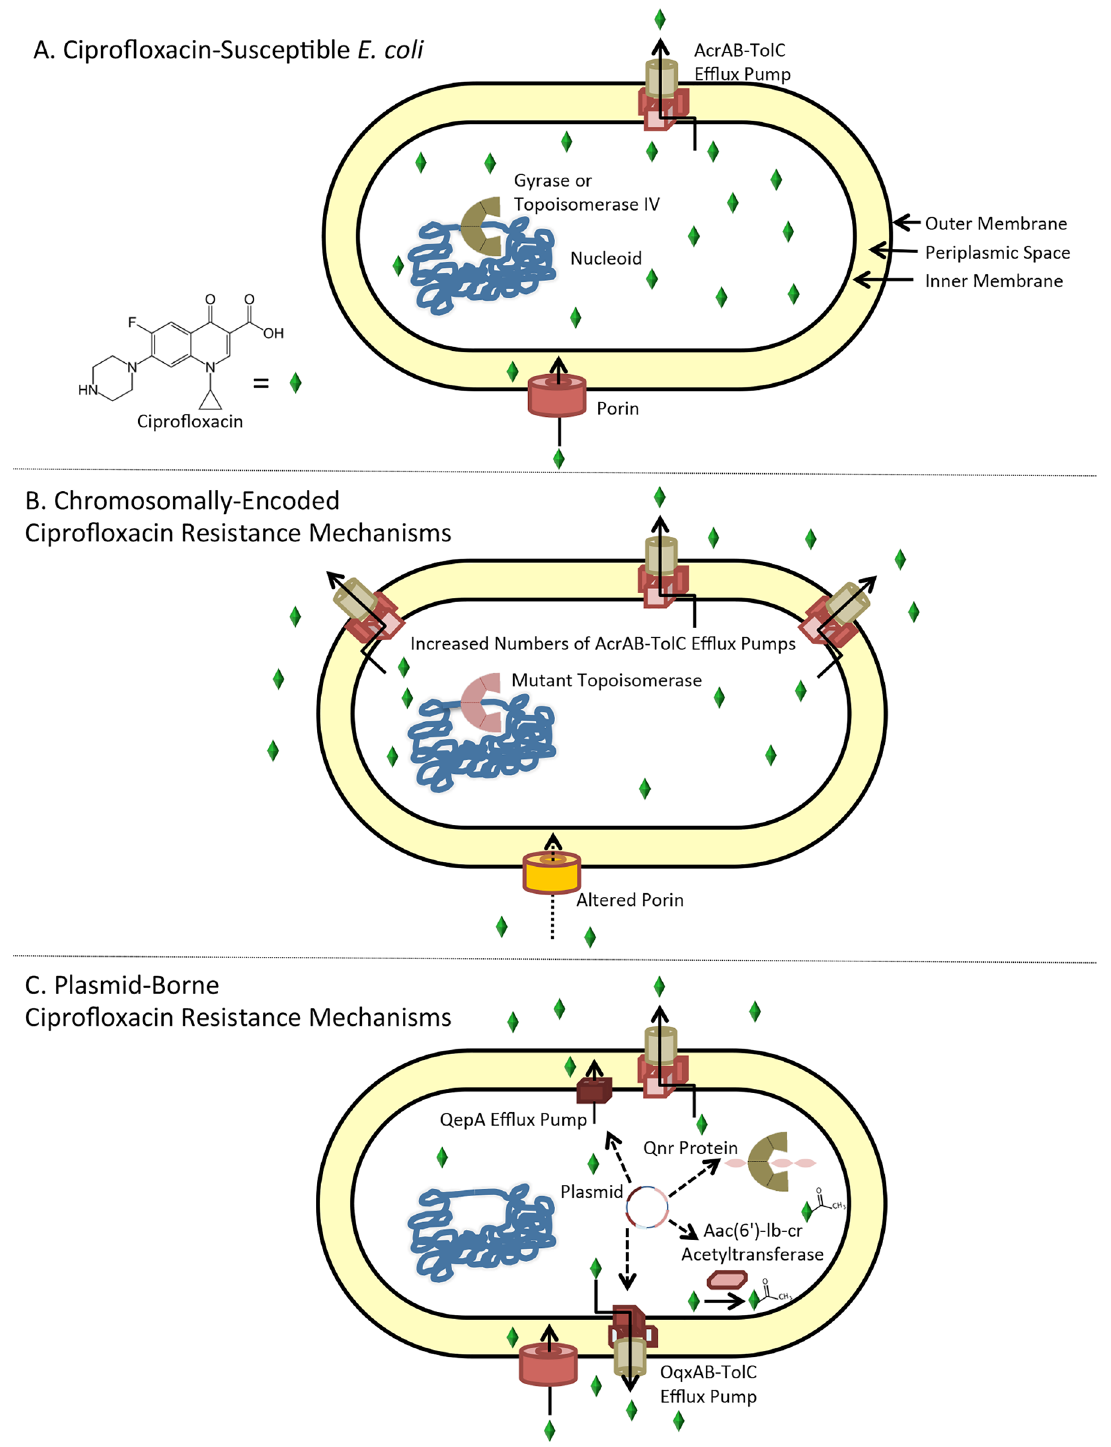
Fig 2. Schematic showing known ciprofloxacin resistance mechanisms in E . coli . (A) Ciprofloxacin-susceptible E . coli . The inner and outer membranes intrinsically protect the bacterium. Also depicted are the AcrAB-TolC efflux pump, porin, and DNA gyrase (or topoisomerase IV) interacting with the DNA nucleoid (in blue). Ciprofloxacin (green diamond) can diffuse through the membranes but also accesses the cell via porins. Ciprofloxacin forms a ternary complex with the topoisomerase bound to DNA, resulting in cell death. (B) Chromosomally encoded ciprofloxacin resistance mechanisms. Altered porin(s), mutant gyrase (and perhaps also topoisomerase IV), and